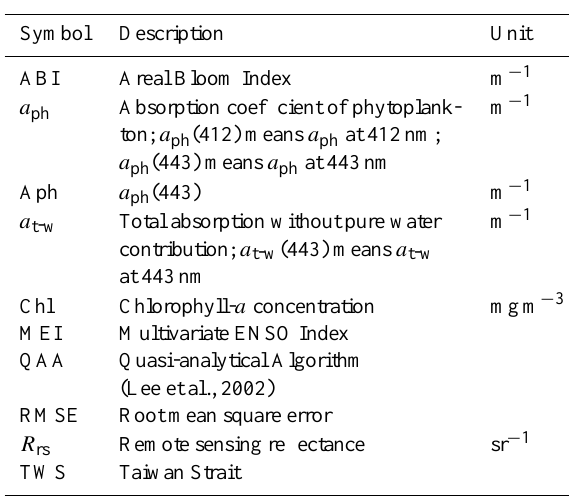
Table 1. Symbols, abbreviations and description.